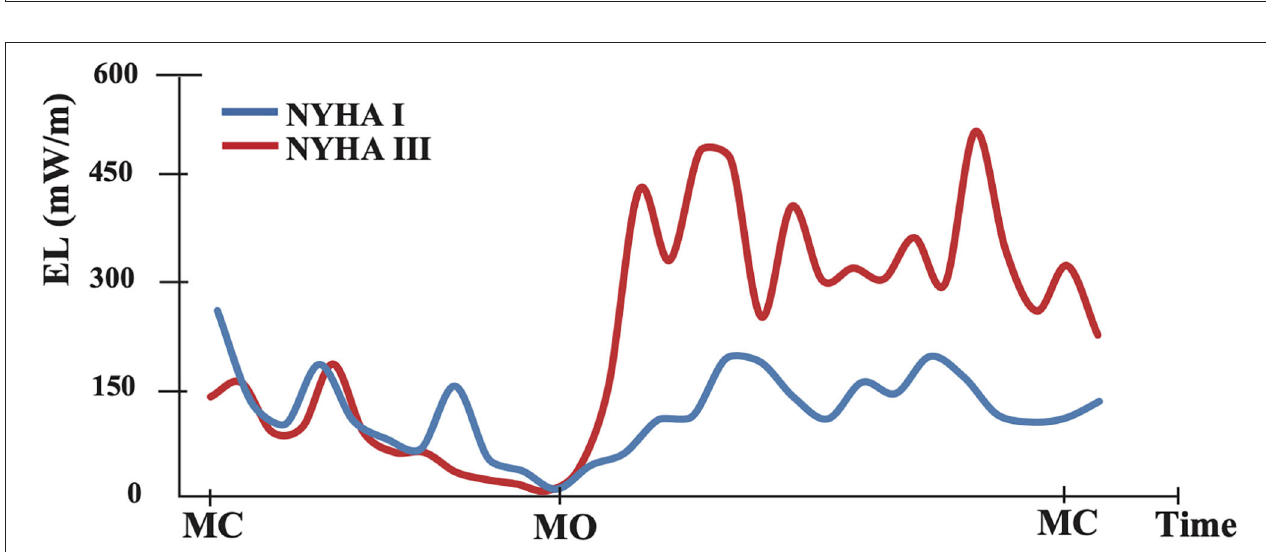
FIGURE 1 | Visualization of blood flow energy loss and blood flow by vector flow mapping. These figures show EL. Brightness indicates high energy loss. The AR jet collides with mitral inflow, which causes left ventricular vortex turbulence and high dissipative EL. (A) Asymptomatic case (NYHA I), (B) symptomatic case (NYHA III). Early diastole, The early phase of the diastolic period; Systolic, Systolic phase; IVCT, The isovolumic contraction phase; IVRT, The isovolumic relaxation phase; Late diastole, The late phase of the diastolic period.